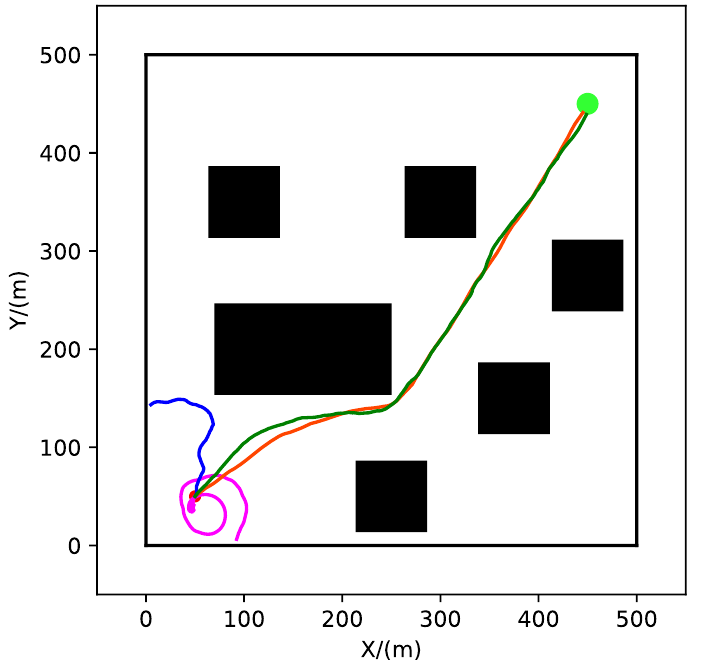
Figure 8. Pretraining process of SAC and DQN. • : AUV; • : Goal; (cid:4) : Obstacle; —: SAC training episode 1 trajectory; —: SAC training episode 6000 trajectory; —: DQN training episode 1 trajectory; —: DQN training episode 6000